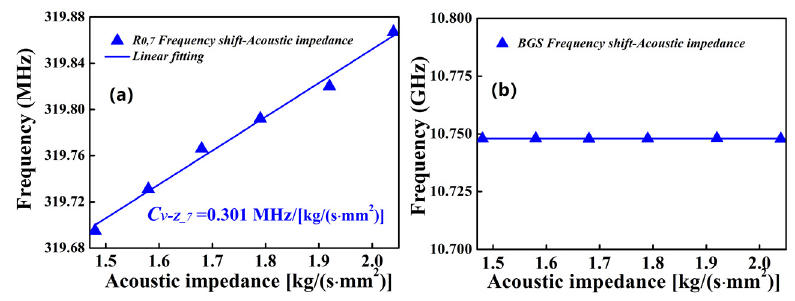
Figure 9. Frequency shift for ( a ) R 0,7 -induced FBSS and ( b ) BGS as a function of acoustic impedance. Different from refs. [14,20], the abovementioned experimental results in which the impedance R 0,7 -induced FBSS and BGS have their individual frequency shift dependencies on temperature and acoustic impedance may provide a novel discriminative measure- ment method of temperature and acoustic impedance.